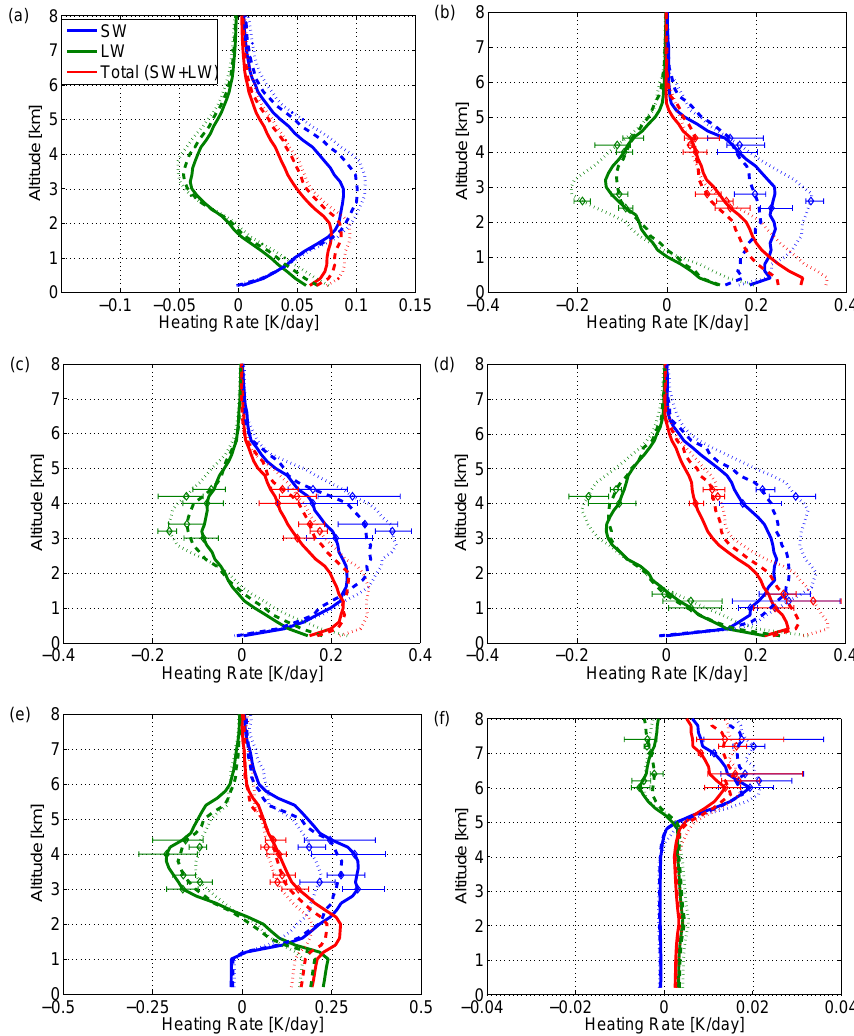
Fig. 11. Vertical distribution of the heating rates in K/day due to SW radiation (blue lines), LW radiation (green lines), and total radiation (red lines) in (a) the entire region of interest, (b) the Arabian Sea, (c) the Ganges Plains, (d) the Indus Plains, (e) the Taklamakan Desert, and (f) the Tibetan Plateau. Simulation with MODIS surface albedo. Note the different scalings of the respective x-axis. Data displayed separately for MAM 2007 (solid lines), 2008 (dotted lines), and 2009 (dashed